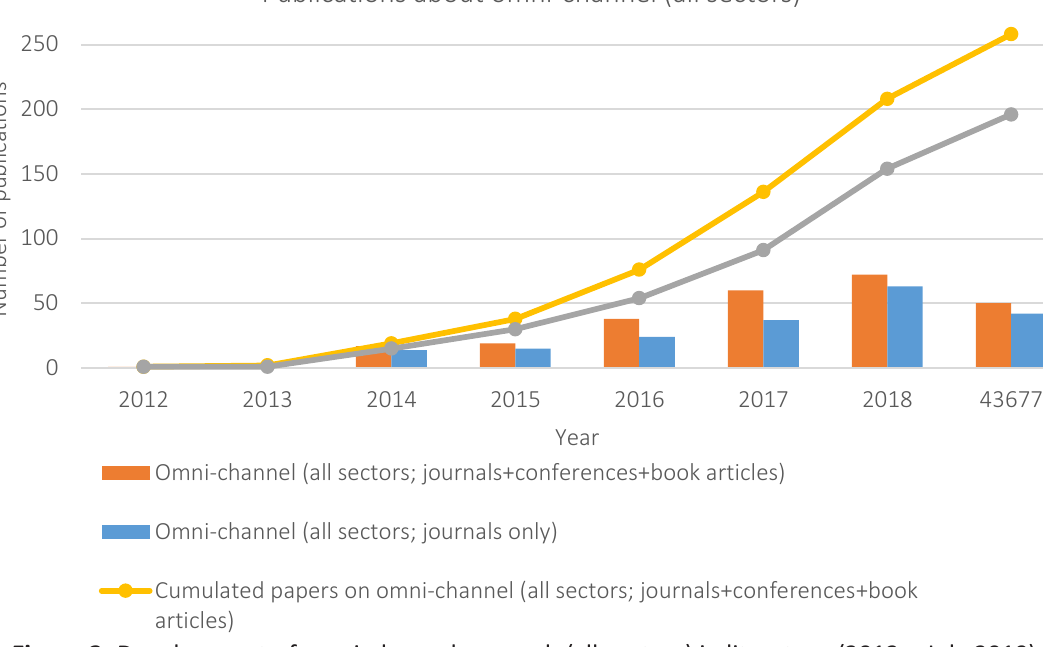
Figure 2. Development of omni-channel research (all sectors) in literature (2012 – July